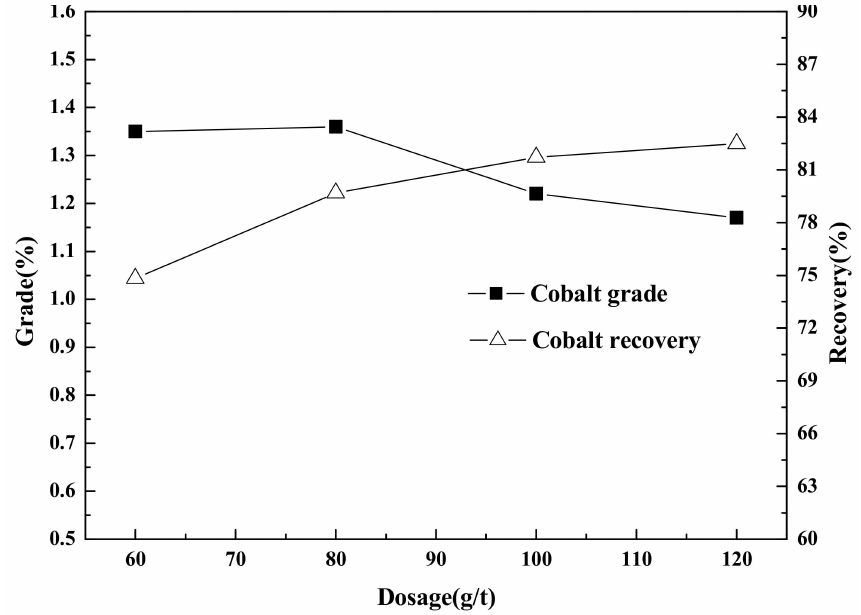
Figure 4. E ff ect of copper sulfate dosage on cobalt grade and recovery in